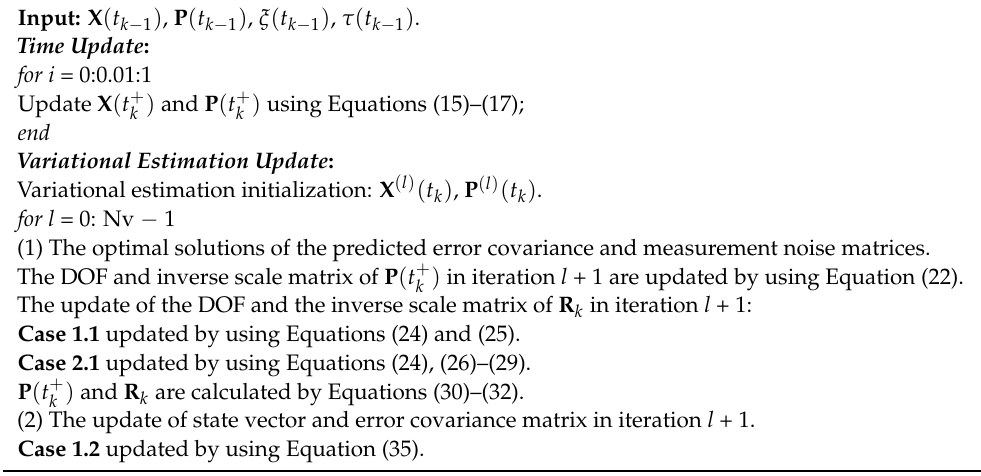
Algorithm 1: The proposed switched variational estimation filtering